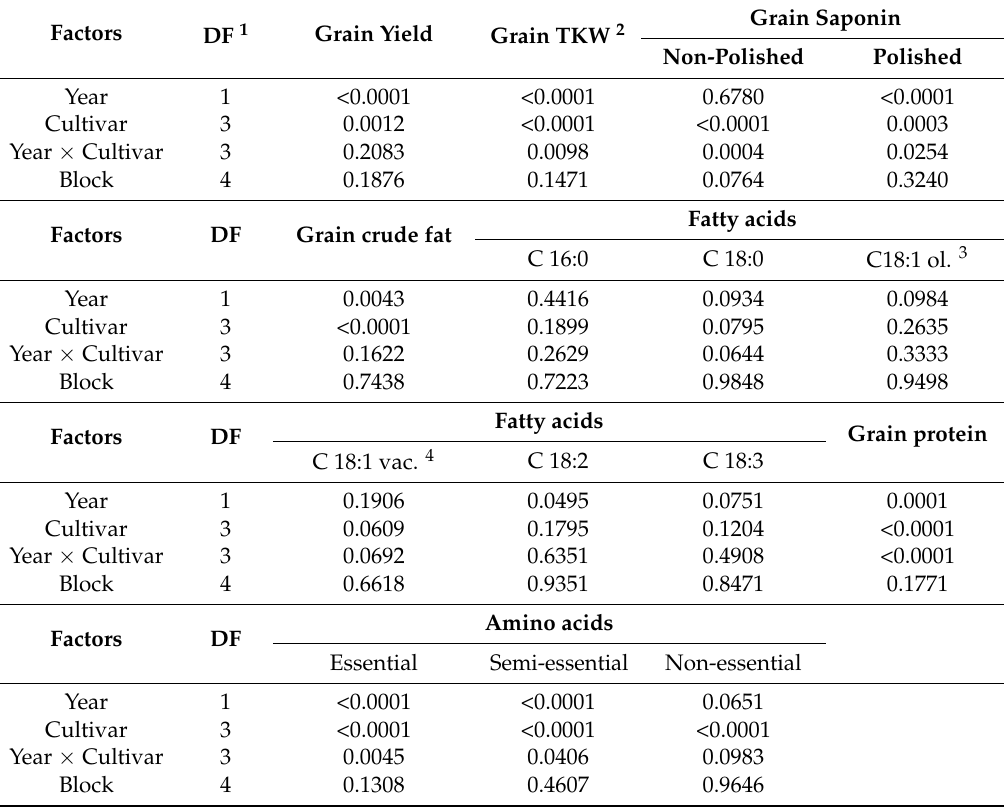
Table 4. Results of ANOVAs (factors, degrees of freedom and p -values) carried out for the different yield- and